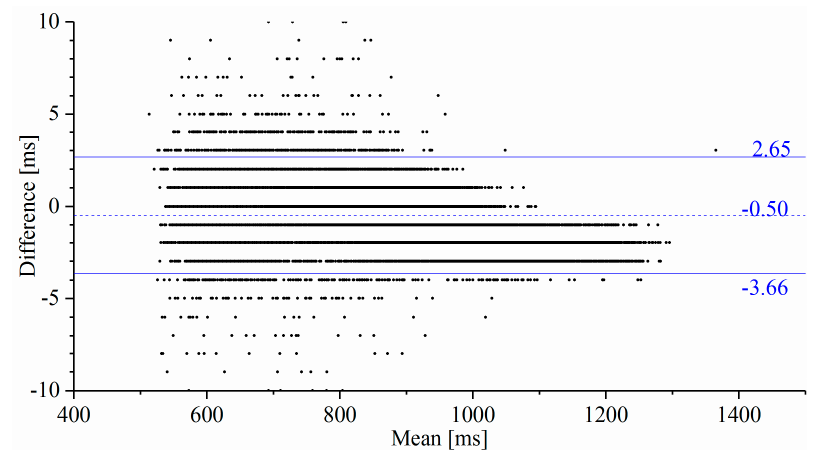
Figure 3. Bland–Altman plot comparing the RRIs obtained from the reference ECG and the proposed system. The measurement bias indicated by the dashed-line and the stochastic error range indicated by the solid lines defined by the limits of agreement are sufficiently low for HRV analysis. No significant proportional bias is observed in the result of the regression analysis of this plot. Table 3. Measured failure rate for all subjects.